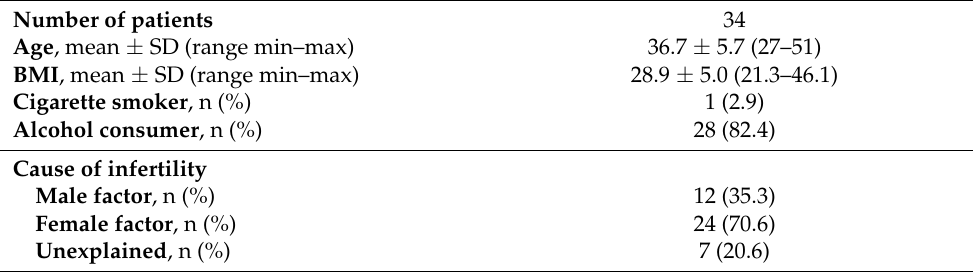
Table 1. Demographics of the study